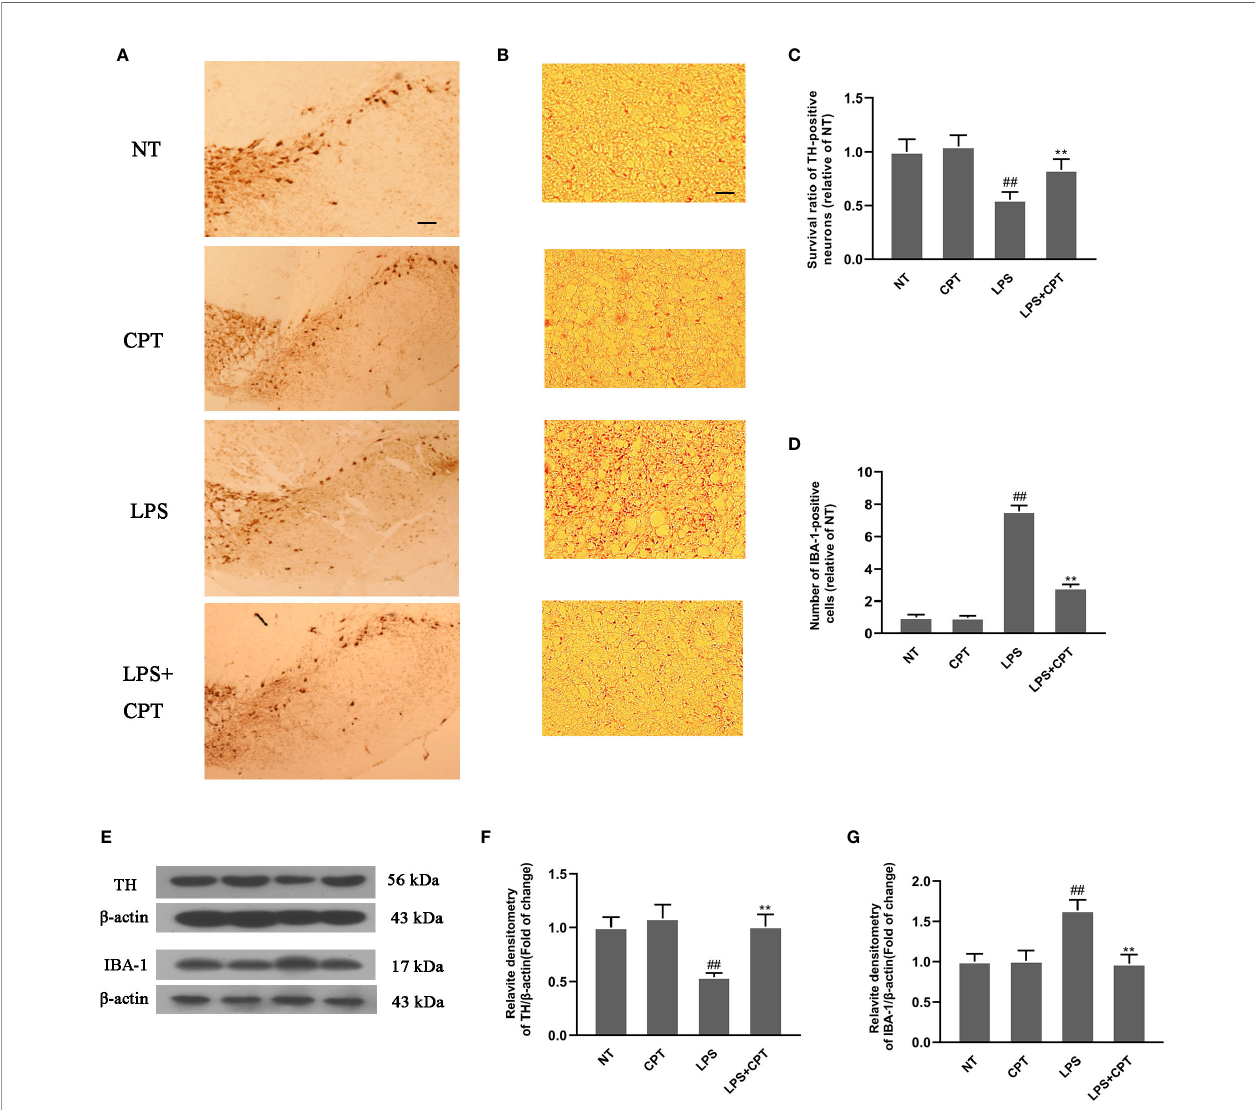
FIGURE 2 | CPT treatment decreases dopaminergic neurons ’ degeneration and over-activation of microglia in LPS- injected PD mice. Experiment mice were anesthetized and sacri fi ced to obtain the brains on the 28th day after LPS injection. (A, C) The numbers of TH-positive cells in the SN were examined using immunohistochemistry (the scale bar represents 200 m m). (B, D) The numbers of IBA-1-positive cells in the SN were examined using immunohistochemistry (the scale bar represents 50 m m). (E – G) The protein level of TH and IBA-1 in the midbrain was examined using western blot. Results are shown as means ± SD (n= 5). ## p < 0.01 vs. the no-treatment (NT) group; **p < 0.01 vs. the LPS-injected